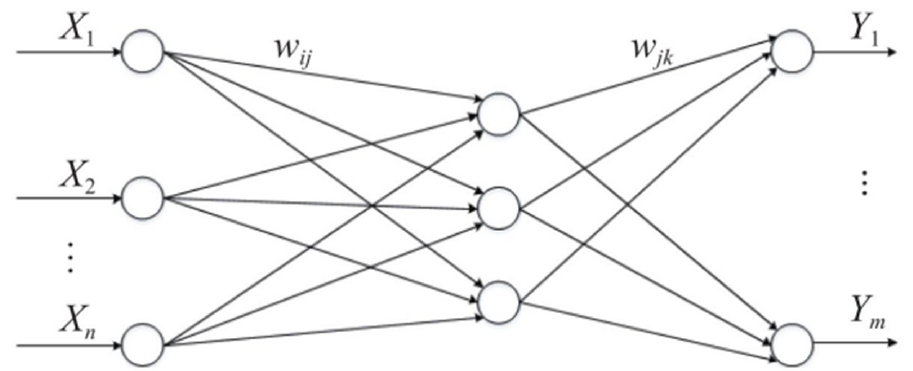
Figure 6. Structure diagram of the BP neural network.